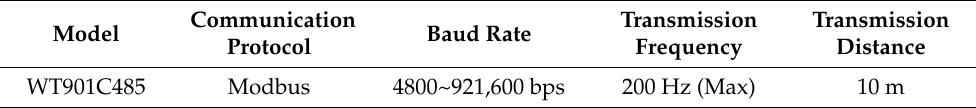
Table 12. The parameters of the 3-axis attitude sensor.